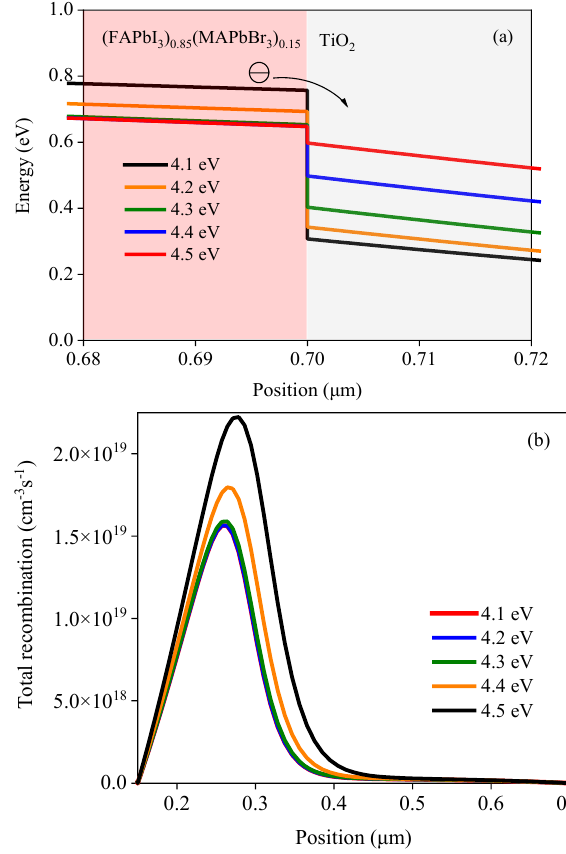
Figure 6. Effect of the electron affinity of TiO 2 on the band structure and total recombination: ( a ) band structure under different electron affinities of TiO 2 and ( b ) total recombination under different electron affinities of TiO 2 .